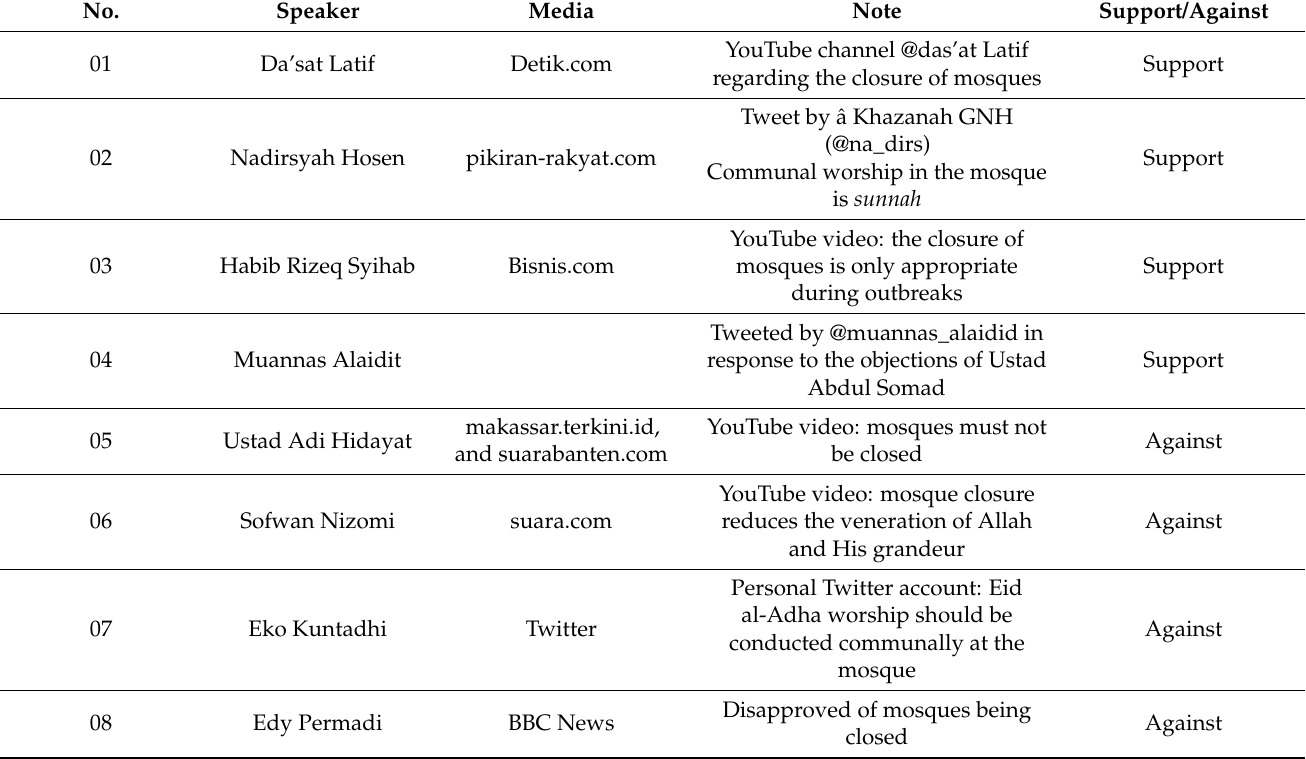
Table 1. Media Trends on Worship Restrictions during the COVID-19